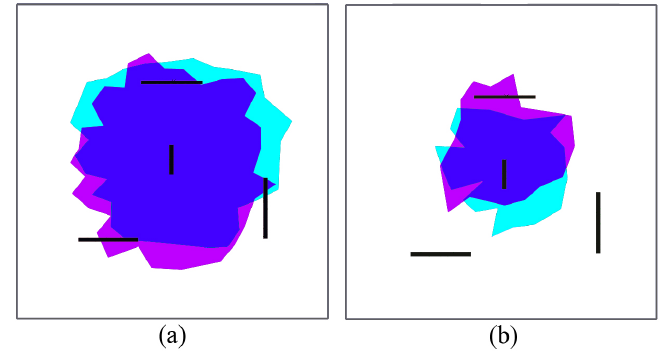
Figure 11. Network configuration when: ( a ) 0%; ( b ) 12.5%; ( c ) 25%; ( d ) 50% and ( e ) 70% of the nodes are dead (figures are scaled 1:10 m).